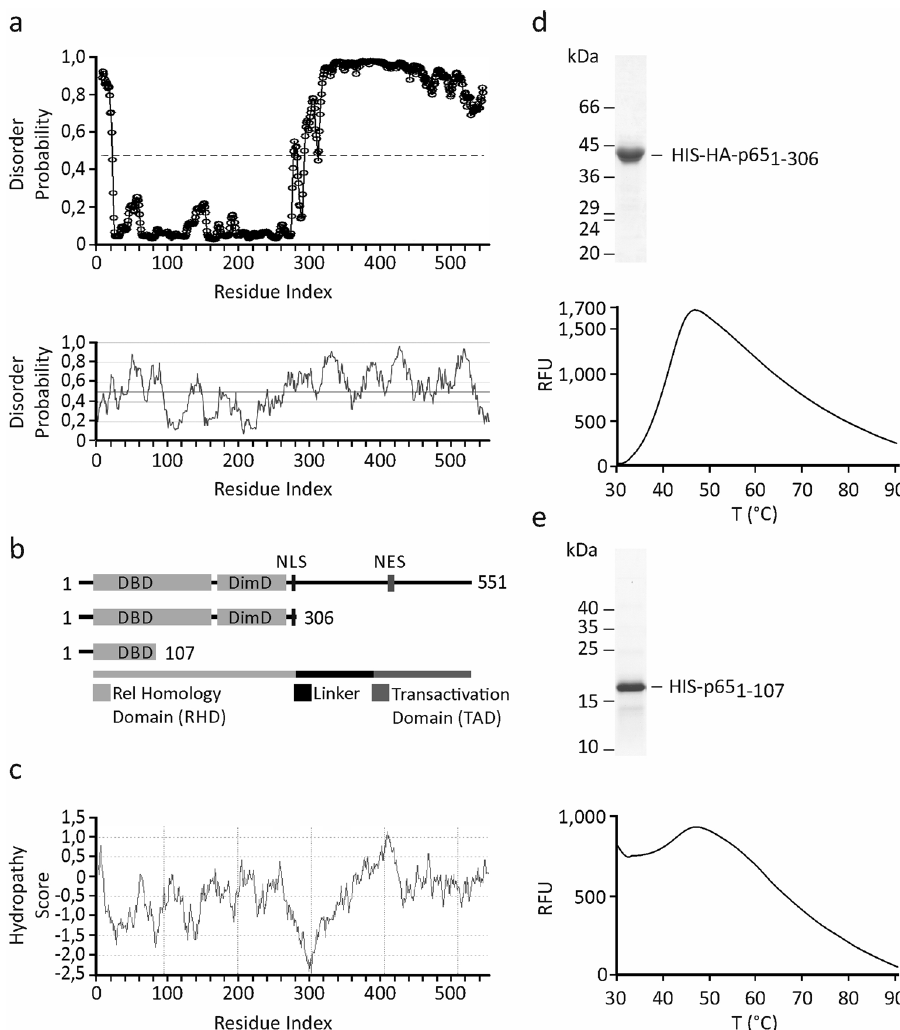
Figure 1. Design, purification and thermal stability of p65/RelA peptide probes. ( a ) Prediction of protein disorder using the SPOT-disorder (upper) and IUPred (lower) web servers for the p65/RelA subunit of NF-κB. The IUPred output was generated using the long disorder option. ( b ) Scheme of the p65/RelA protein and its deletion variants representing the NF-κB probes. The DNA-binding (DBD) and dimerization (DimD) subdomains, and nuclear import (NLS) and export (NES) signals are indicated. ( c ) The hydrophobic properties of p65/RelA were analysed using the ExPASy Protscale web server. ( d , e ) SDS-PAGE analysis of HIS-tagged p65 1-306 and p65 1-107 proteins expressed in E. coli and purified by affinity chromatography. The thermal stabilities of purified proteins were analysed by measuring SYPRO Orange dye fluorescence over a temperature (T) range of 25–95 °C using a real-time PCR thermocycler. Representative unfolding curves are shown. RFU relative fluorescence